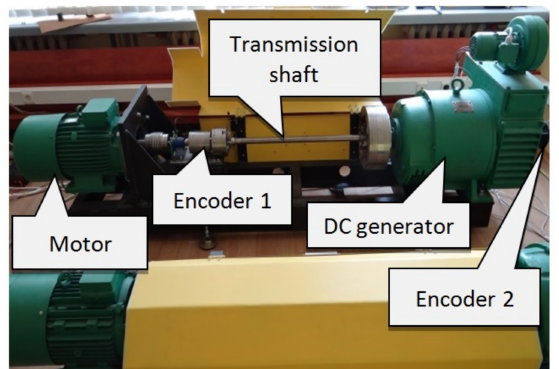
Figure 1. Stand for testing a drive system with elastic coupling.